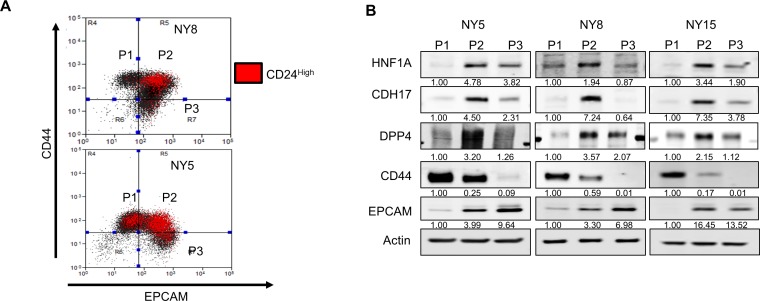
Cancer stem cell properties of PDA cell subpopulations.(A) Co-localization of CD24High surface expression with EPCAM and CD44 expression is highlighted in red. (B) Western blot analysis of HNF1A and target genes CDH17 and DPP4, as well as CD44 and EPCAM as subpopulation controls in sorted PDA cells. Quantitation of proteins is indicated below the respective blots.